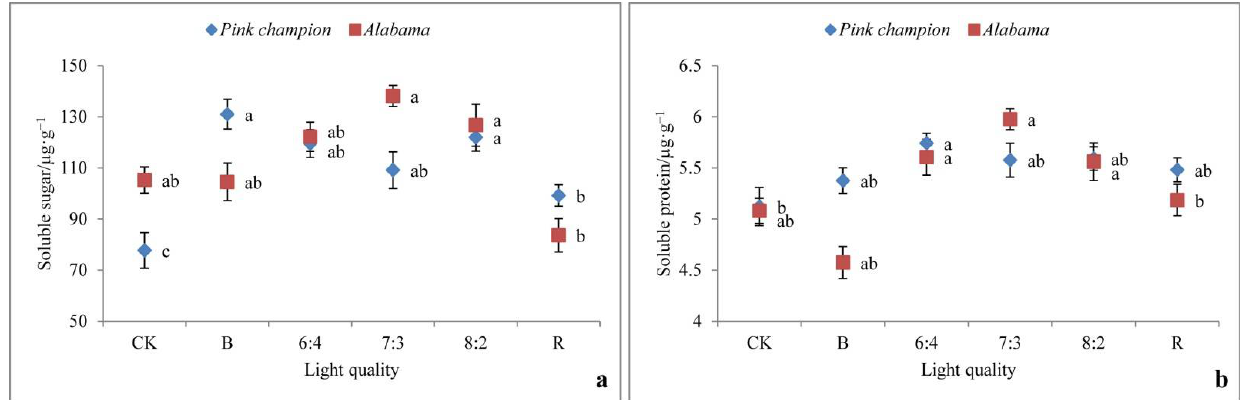
Figure 6. Effects of different light qualities on soluble sugar ( a ) and protein ( b ) of Anthurium ‘Pink Champion, Alabama’. The statistical analysis has been carried out separately for each cultivar. Vertical bars indicate standard error ( n = 5). Different letters represent a significant difference at p < 0.05 among treatments by the Duncan’s multiple range test.